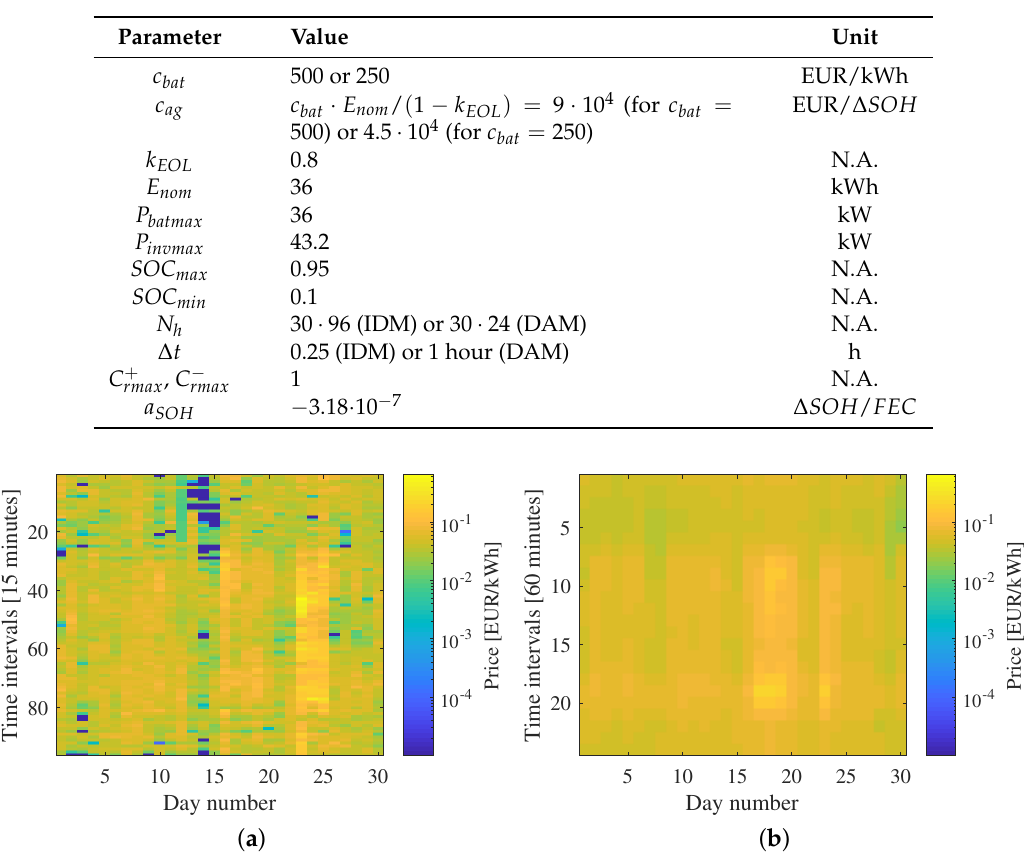
Figure A1. Price distribution for ( a ) the intraday market; and ( b ) the day-ahead